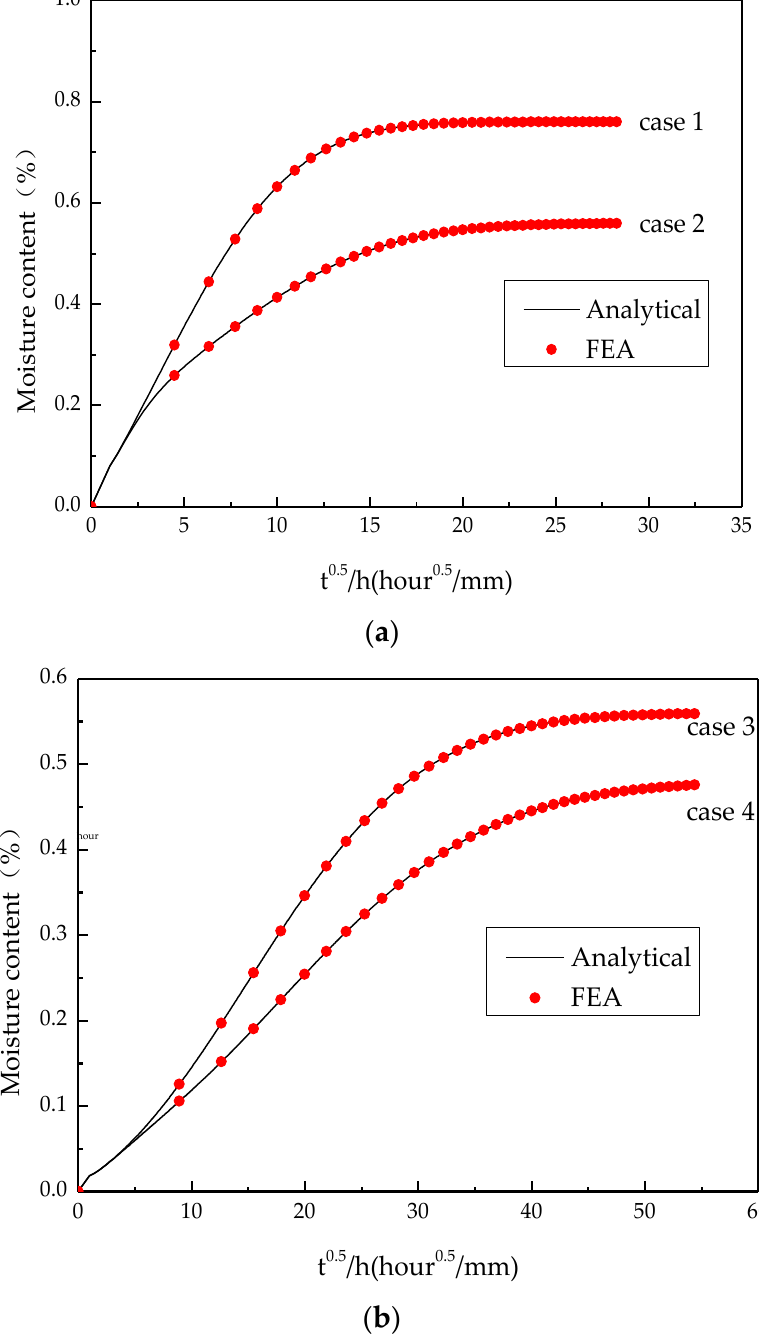
Figure 5. The comparison between analytical and FEA results, ( a ) Case 1 and case 2; ( b ) Case 3 and case 4.